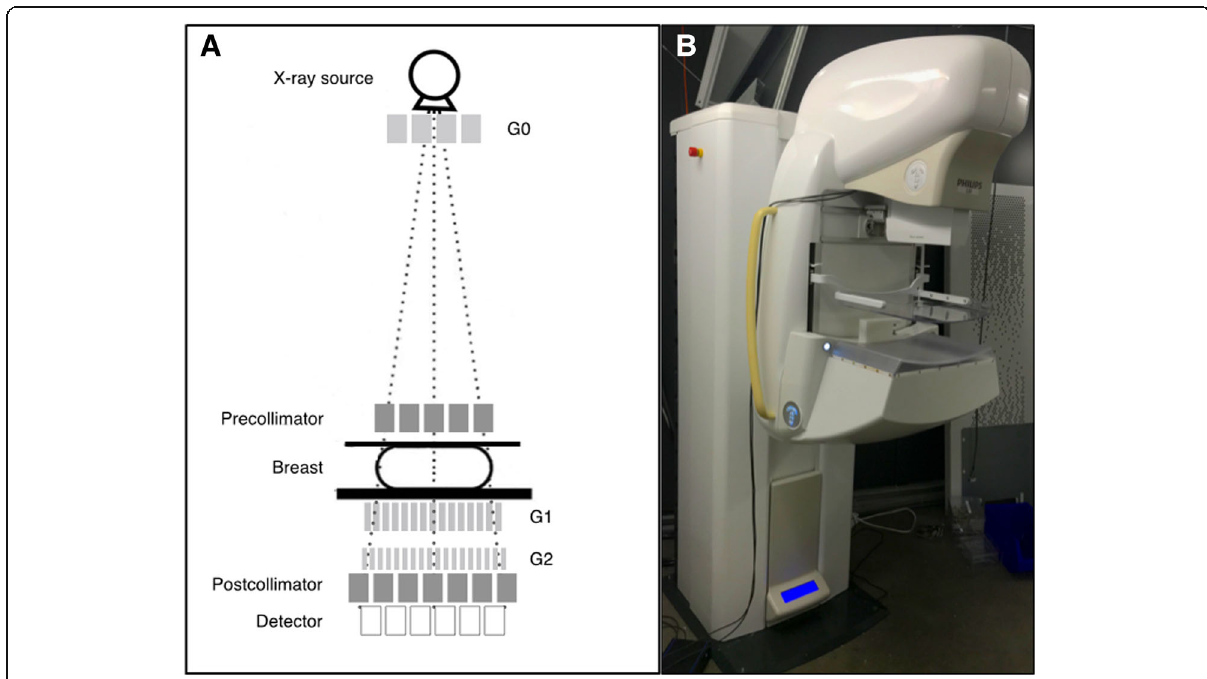
Fig. 1 a Sketch of the grating interferometer installed in a Philips MicroDose mammography system. The gratings are thin diffraction elements placed in the beam perpendicular to the optical axis, containing periodical line structures that absorb x-rays and/or shift their phase. A source grating (G0), a beam splitter grating (G1), and an analyser grating (G2) contribute at different steps to the recording of the phase and dark-field signals. b Photo of the grating interferometry mammography investigational device used in the